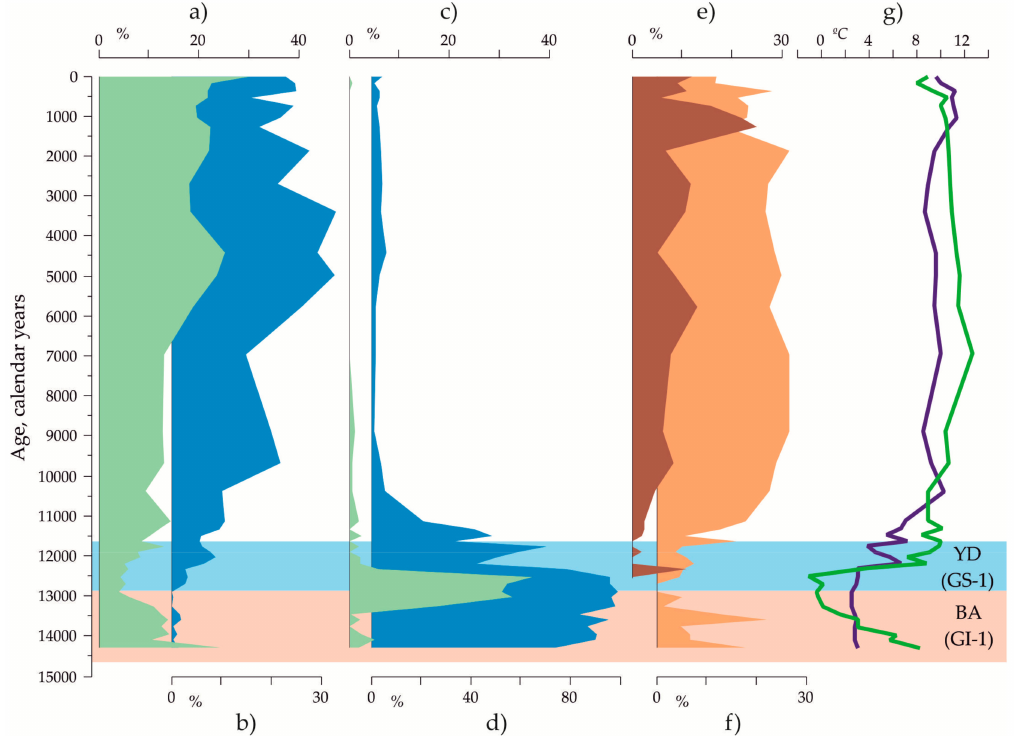
Figure 5. Down-core distribution of the main radiolarian, planktic and benthic foraminiferal species. Temperate open North Atlantic species: ( a ) radiolarian L. spiralis/minor group, and ( b ) planktic foraminifera N. pachyderma (dex.). Subpolar/Polar species: ( c ) radiolarian A. setosa , and ( d ) planktic foraminifera N. pachyderma (sin.). Benthic foraminifera: ( e ) G. subglobosa as marker of spring phytodetrital fluxes [20], and ( f ) C. teretis as dweller in soft surface sediment, rich on bacterias, being abundant during the summer [19]. Reconstructed temperature for the 100 m water depth, ( g ): dark-blue line based on the planktic foraminifera, green line based on the radiolarians. Light-blue bar is an interval of the cold YD (Greenland Stadial GS-1), rose bar is an interval of the warm BA (Greenland Interstadial